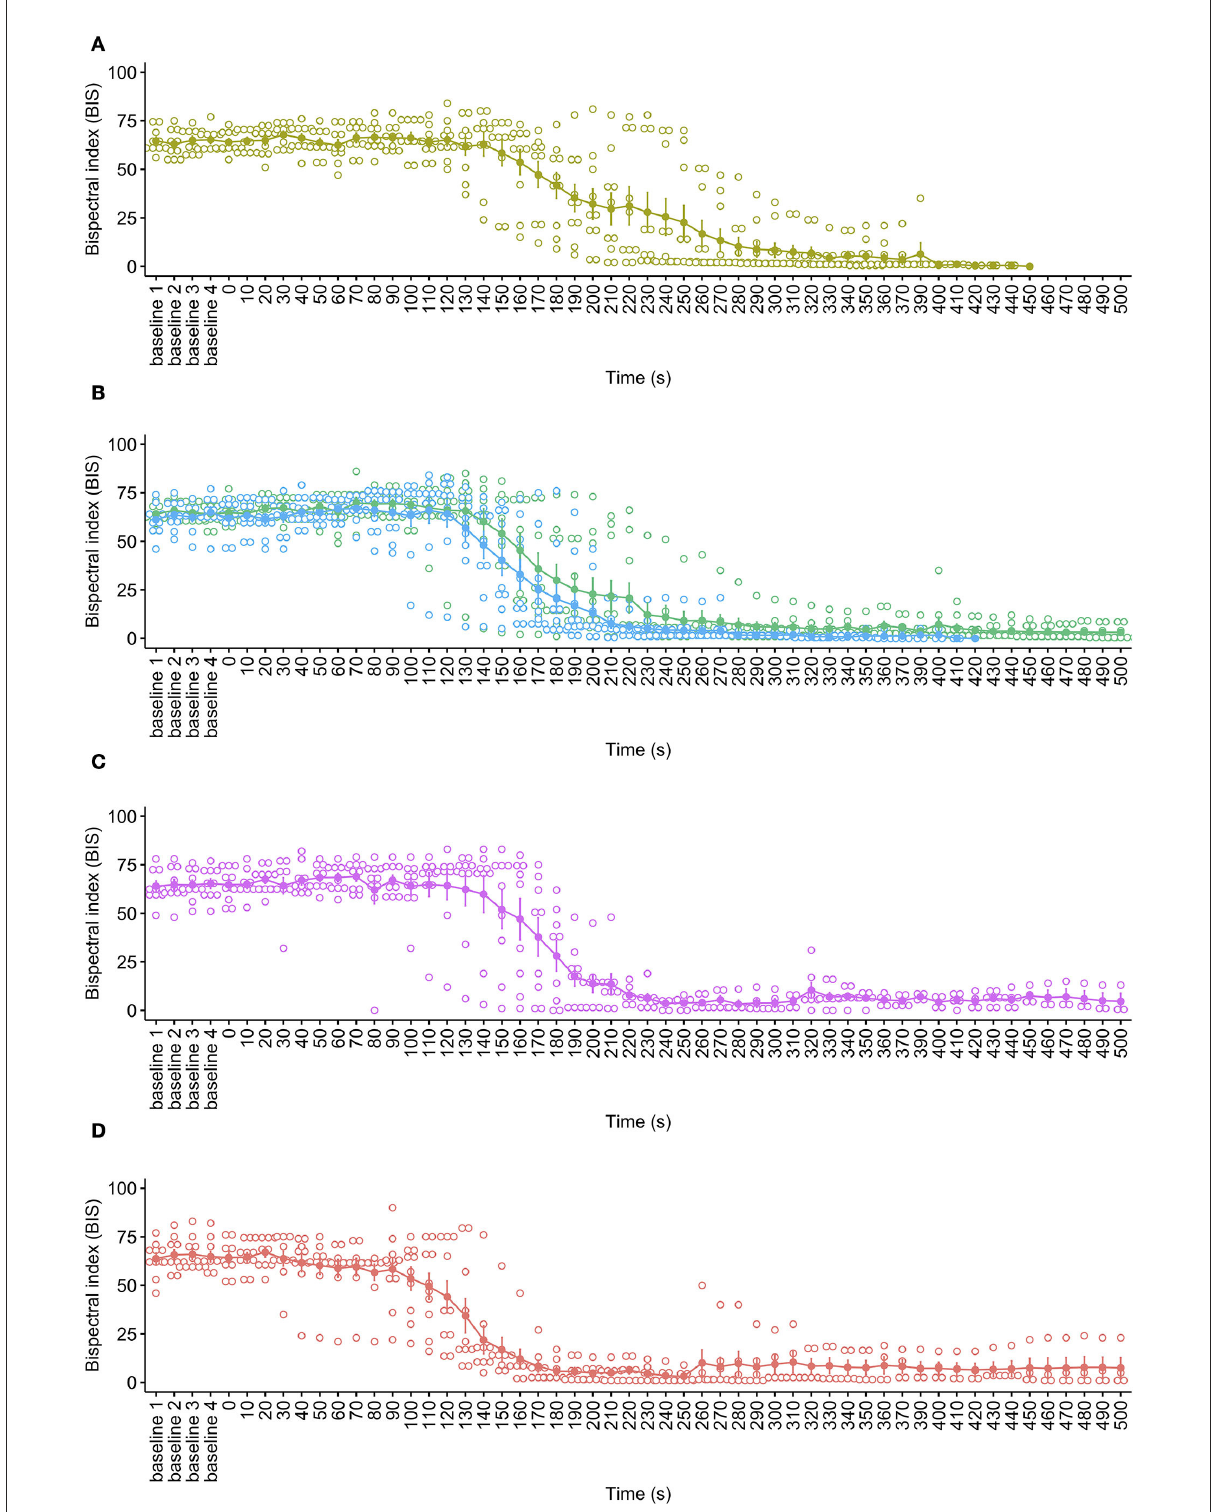
FIGURE5 Mean ± SE bispectral index (BIS) over time for each decompression treatment rate: (A) 40 ms − 1 (yellow); (B) 60 ms − 1 long/720s cycle (green) and 60 ms − 1 short/480s cycle (blue); (C) 80 ms − 1 (pink); and (D) 100 ms − 1 (red). Mean is represented by solid dots with error bars for SE, with hollow dots representing individual raw data points. Due to BIS data becoming increasingly unreliable and sparse as the cycles progressed [e.g., reaching EEG silence ( < 10)], the plots have been limited to the baseline period and the first 500s of the